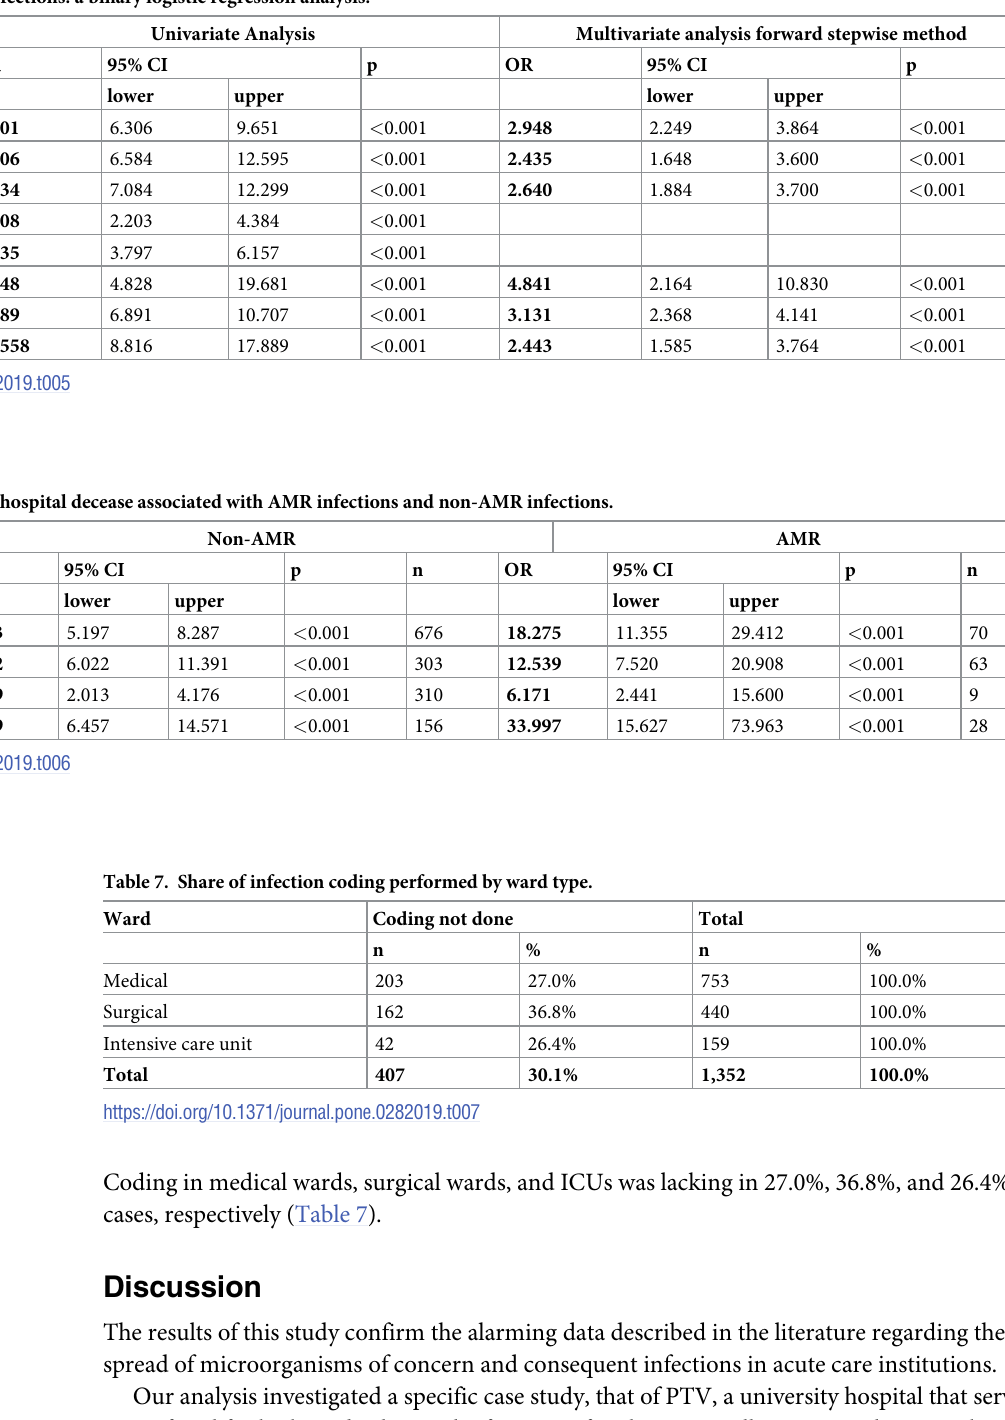
Table 5. Intrahospital decease and infections: a binary logistic regression analysis.